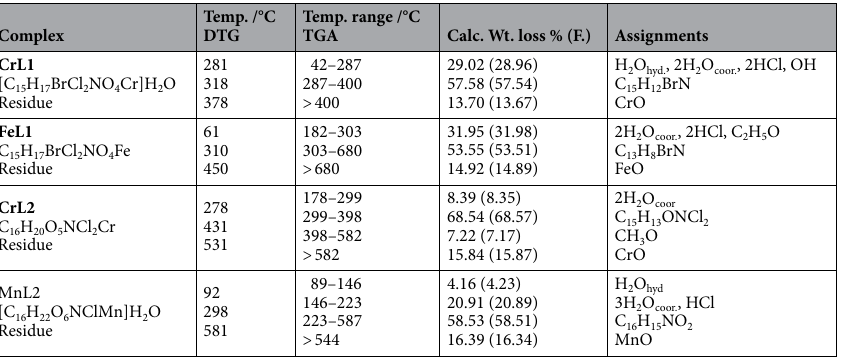
Table 4. Thermal analysis findings for CrL1, FeL1, CrL2, and MnL2 complexes heated at a rate of 10 °C/min to 800 °C from room temperature to 800 °C.